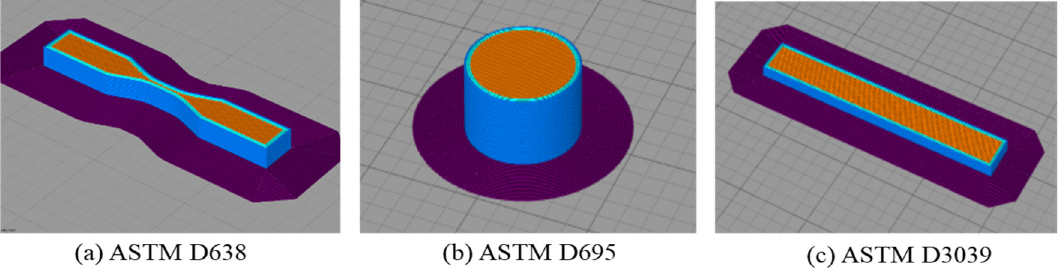
Figure 2. Sliced models for the experiments. ( a ) ASTM D638; ( b ) ASTM D695; ( c ) ASTM D3039. Table 3. Fixed process